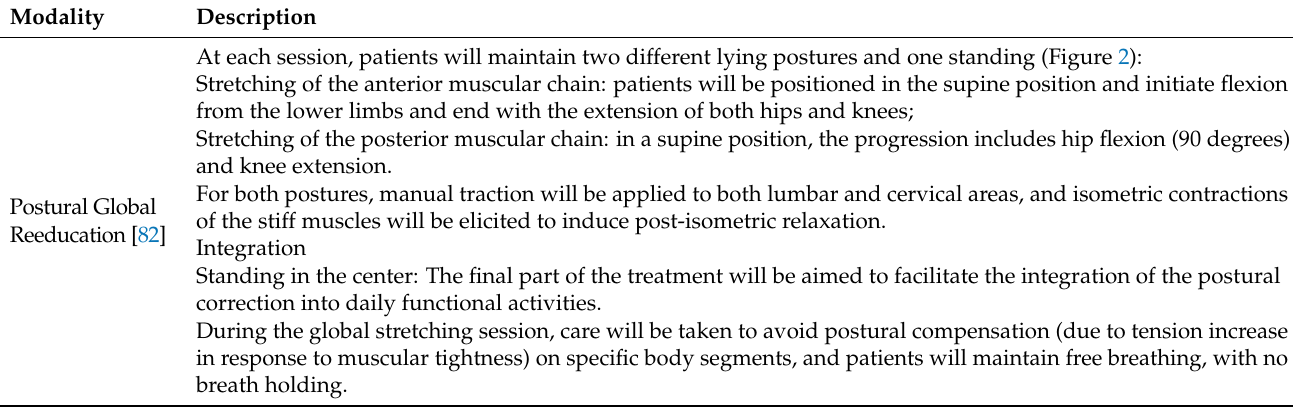
Table 3. Description of exercise programs used in the